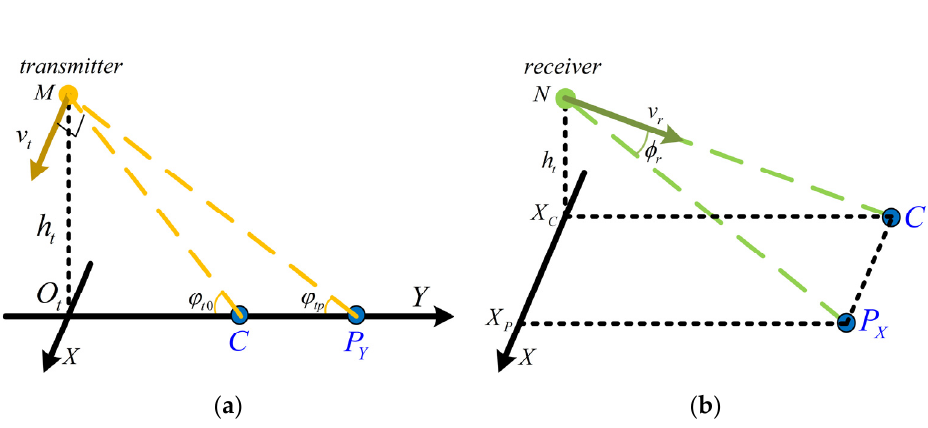
Figure 10. Divisional imaging geometry at the synthetic aperture center time. ( a ) The geometry of the transmitter; and ( b ) The geometry of the receiver.